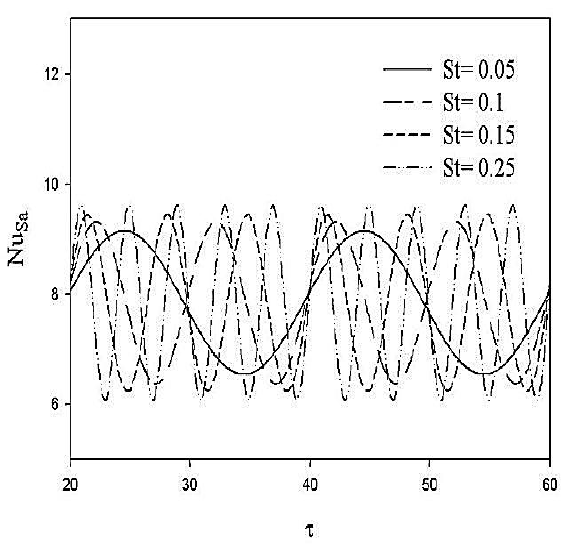
Fig. 8. Effect of volume fraction of nanoparticles ( φ ) and Reynolds number on total Nusselt number at A=0.05 and St=0.1.